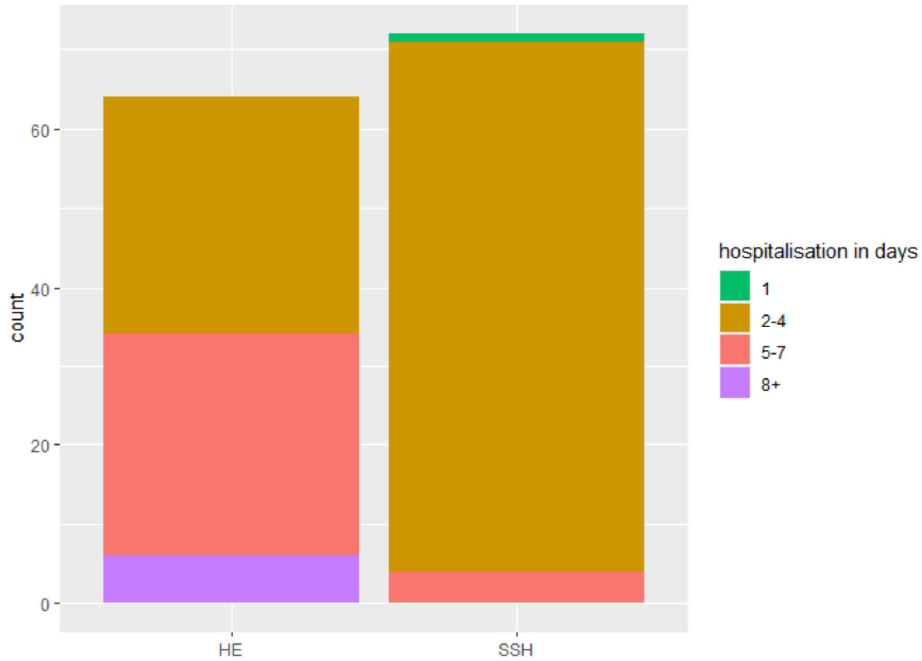
Figure 3 . Hospitalization days .